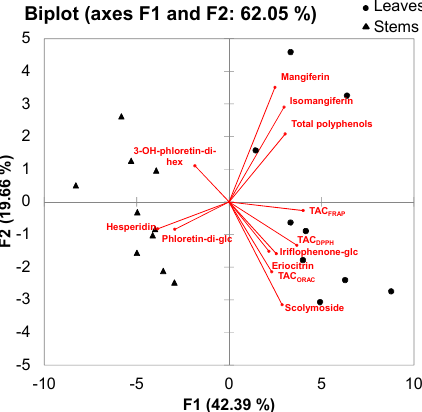
Figure 4. Principal component biplot for phenolic composition and total antioxidant capacity (TAC) of freeze-dried aqueous extracts of green Cyclopia subternata leaves (n = 10) and stems (n = 10).